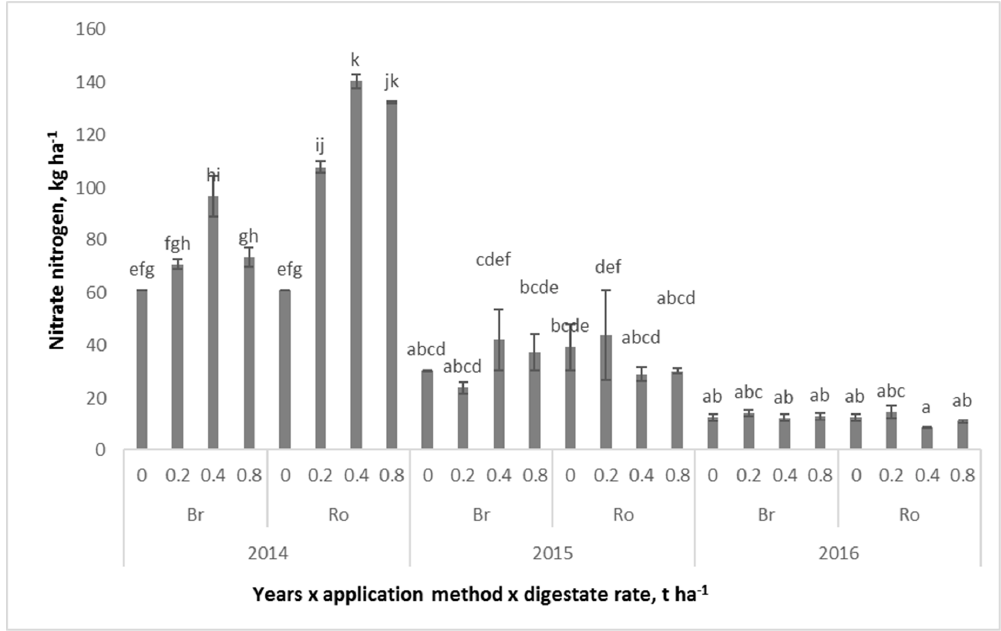
Figure 3. E ff ect of the method and rate of digestate on the post-harvest nitrate–nitrogen content in soil in consecutive years. a Numbers marked with the same letter are not significantly di ff erent; the bars indicate a double standard error of the mean ( n = 4).